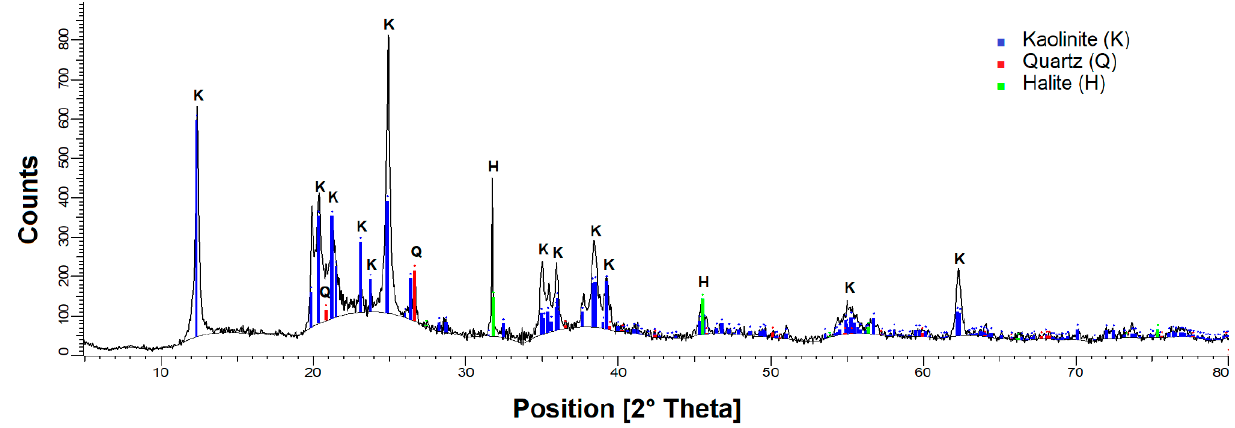
Figure 1. X ‐ ray diffraction spectrum of kaolin particles. Figure 1. X-ray diffraction spectrum of kaolin